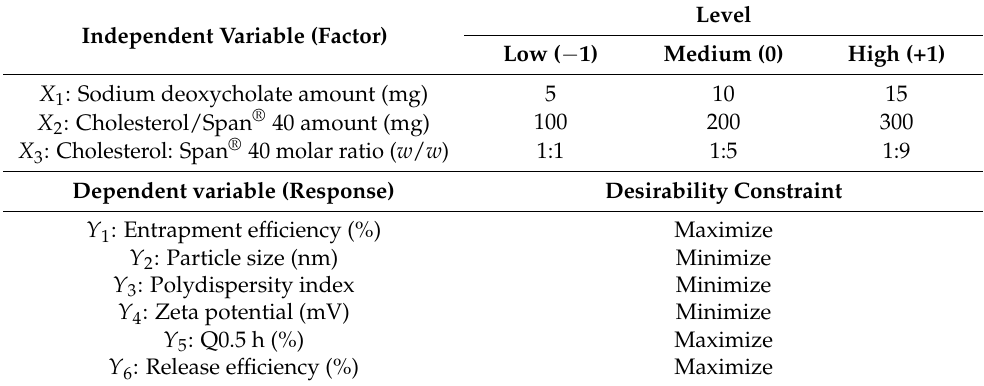
Table 1. Design parameters and experimental conditions for Box–Behnken (3 3 )